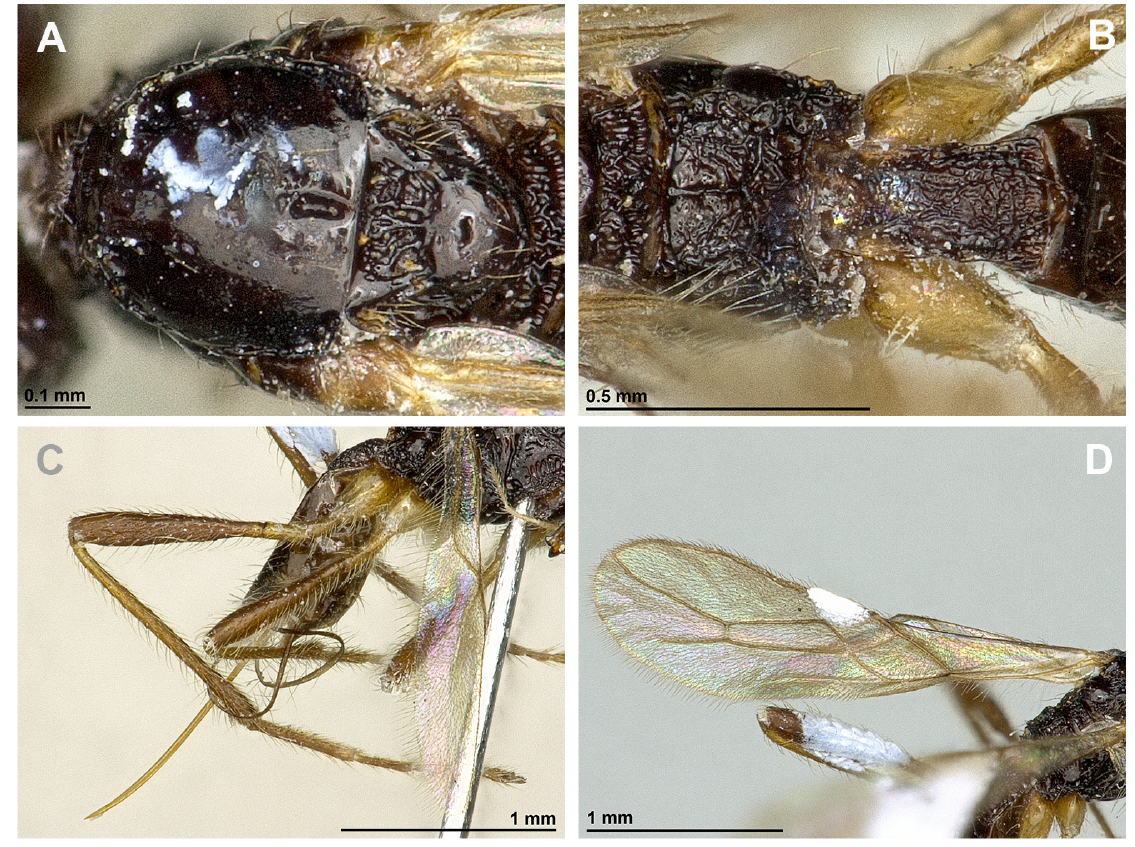
Fig. 14. Asobara elongitarsis van Achterberg, sp. nov., ♀, holotype (RMNH 8234). A . Mesoscutum, dorsal view. B . Propodeum and first metasomal tergite, dorsal view. C . Hind leg, metasoma and ovipositor, lateral view. D . Fore and hind